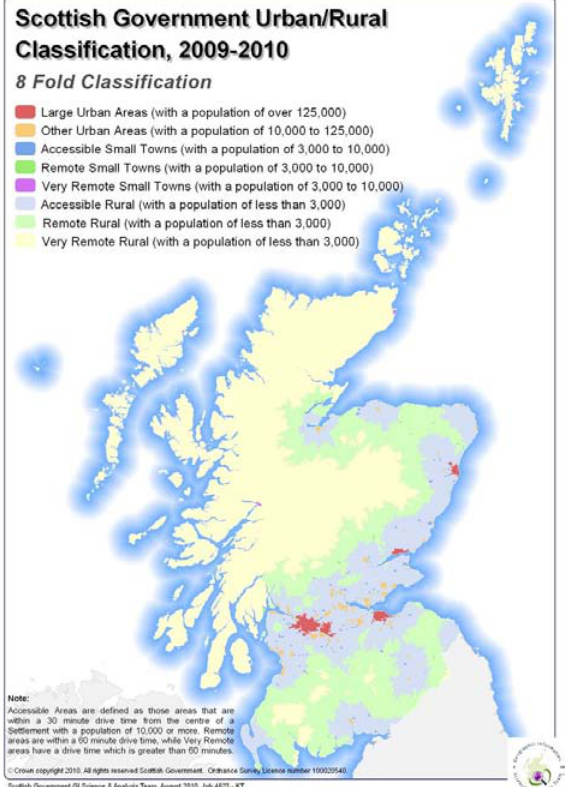
Figure 1 . Scottish Government 8-Fold Urban Rural Classification (Scottish Government, 2010). Scottish Government data on school leavers in rural areas show a relatively high percentage with Higher Education-level entry qualifications and a high percentage entering education or employment, but low participation in Further Education (technical and vocational) (Scottish Funding Council, 2009; Scottish Funding Council, 2010). While a relatively high percentage of people in rural areas have Higher Education qualifications (Scottish Government, 2009), there are significant variations associated with migration. Key drivers of out-migration are limited local employment, limited local training, and participation in Further and Higher Education (Highlands and Island Enterprise, 2009). The idea that you have to “get away to get on” is supported by data collected in remote rural island communities, which show that 78% of those who leave will gain Higher Education qualifications, compared to 29% of those who stay. These leavers are primarily in the 16–24 age range. The report finds in-migrants’ (including returners’) households have higher incomes and tend to have higher educational qualifications than those who remain in the area (Hall Aitken,